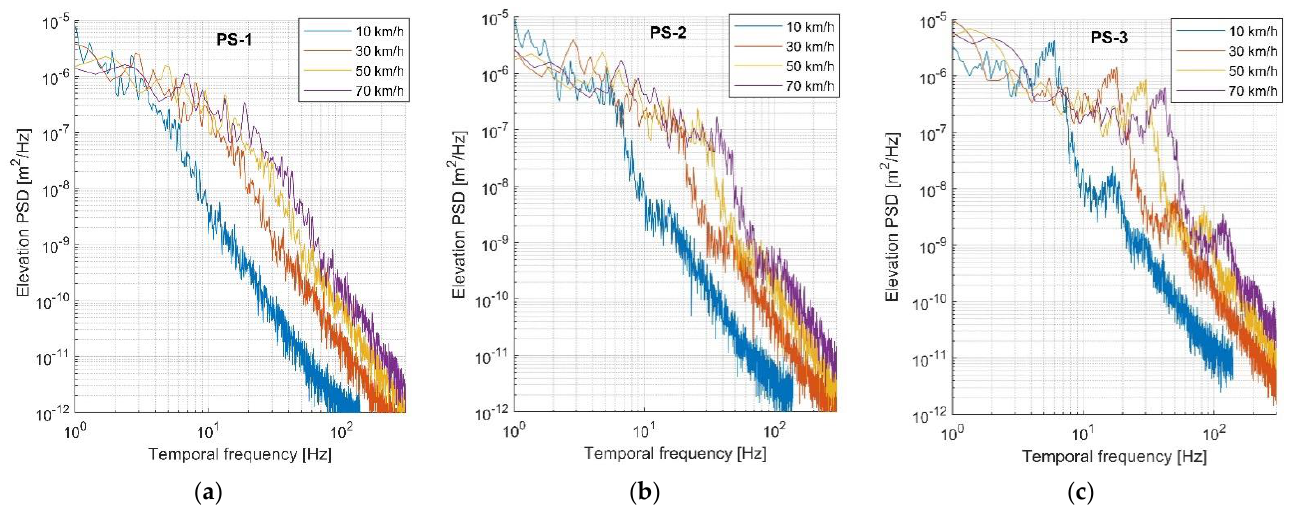
Figure 6. Roughness representation in temporal frequency measured at different driving speeds and pavement surface states: ( a ) PS-1; ( b ) PS-2; ( c ) PS-3.